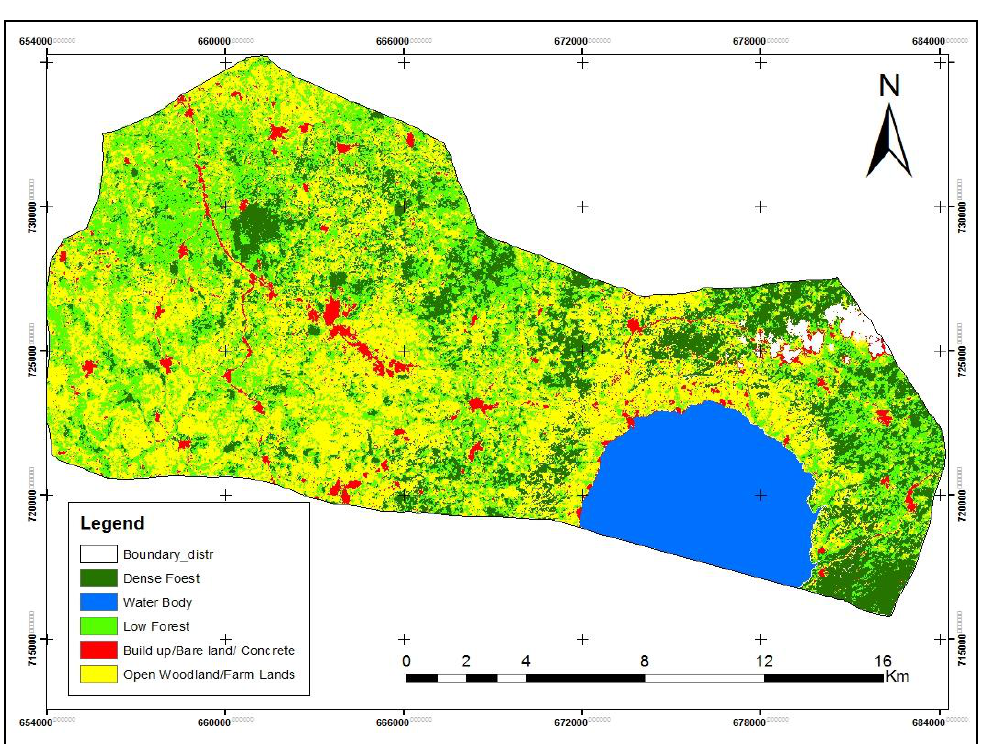
Figure 2. LULC Map of 1986 Landsat 5 TM